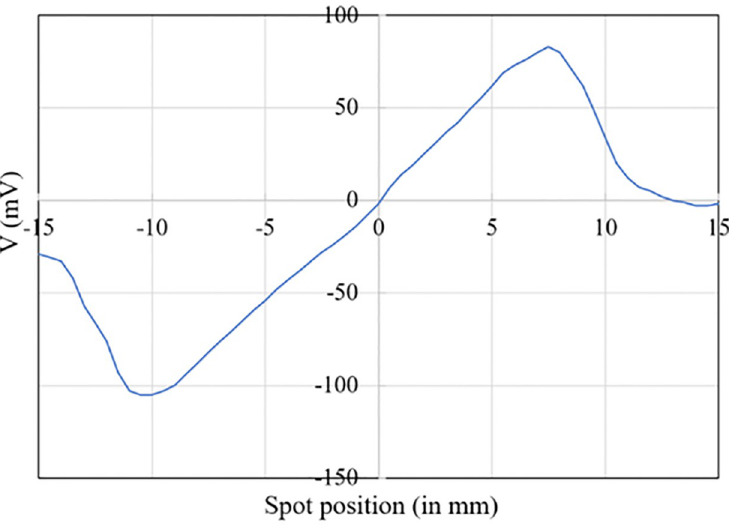
Fig 8. Voltage measurement as a function of the spot position on the PSD (after offset